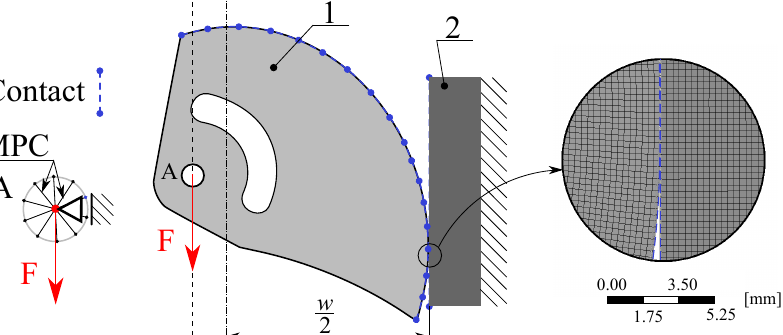
Figure 7. Boundary conditions for the nonlinear computational model (1—scheme of the cam, 2—jaw) and detail of